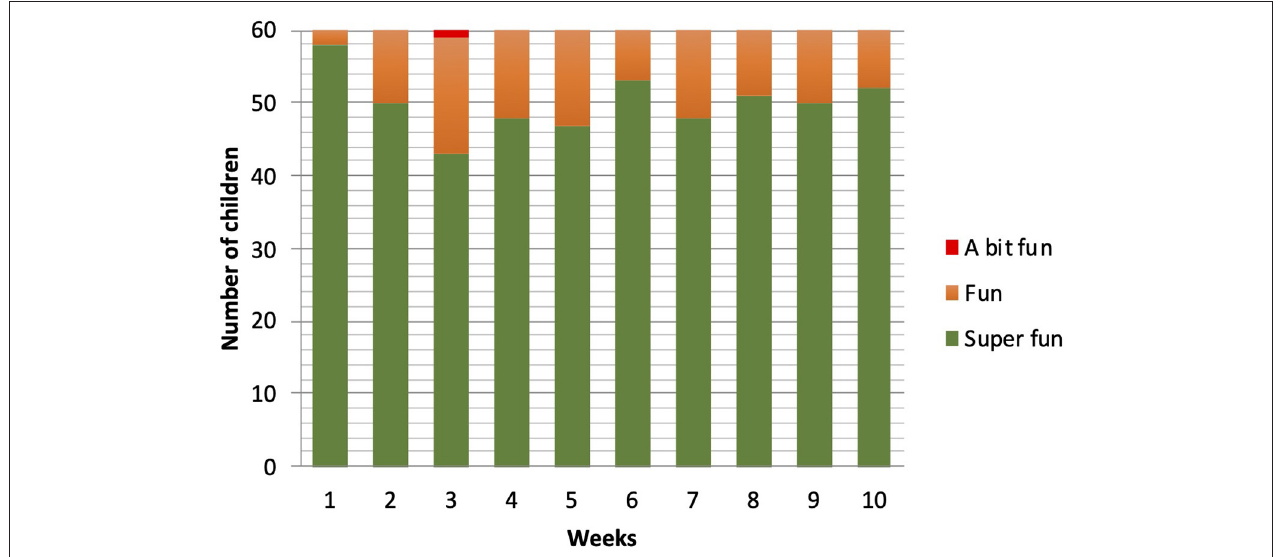
FIGURE 4 | Enjoyment levels reported by the children during the 10 weeks of